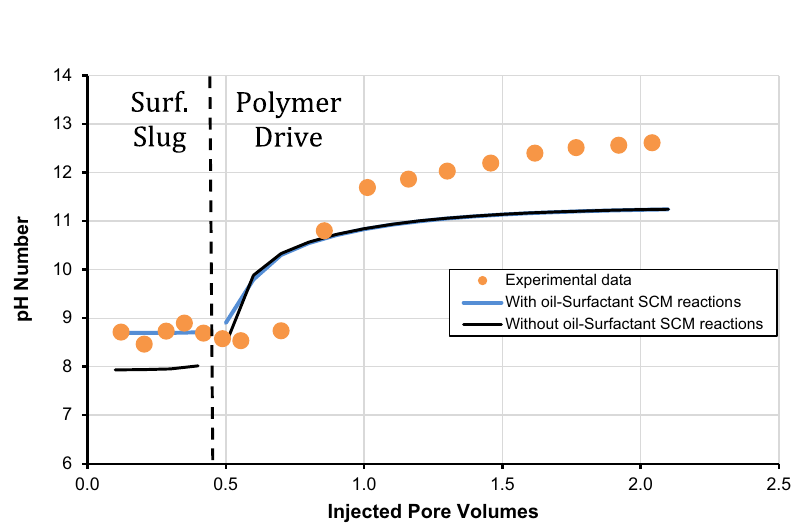
Figure 4. Effect of effluent concentration of surfactant and comparison of with and without the usage of oil- surfactant surface complexation reactions.